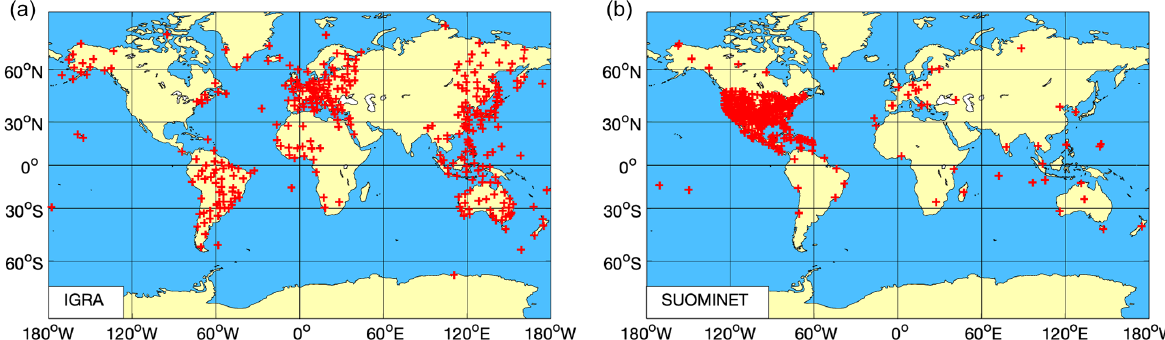
Figure 1. Locations of OLCI-A matchups with IGRA (a) and SuomiNet (b) networks.